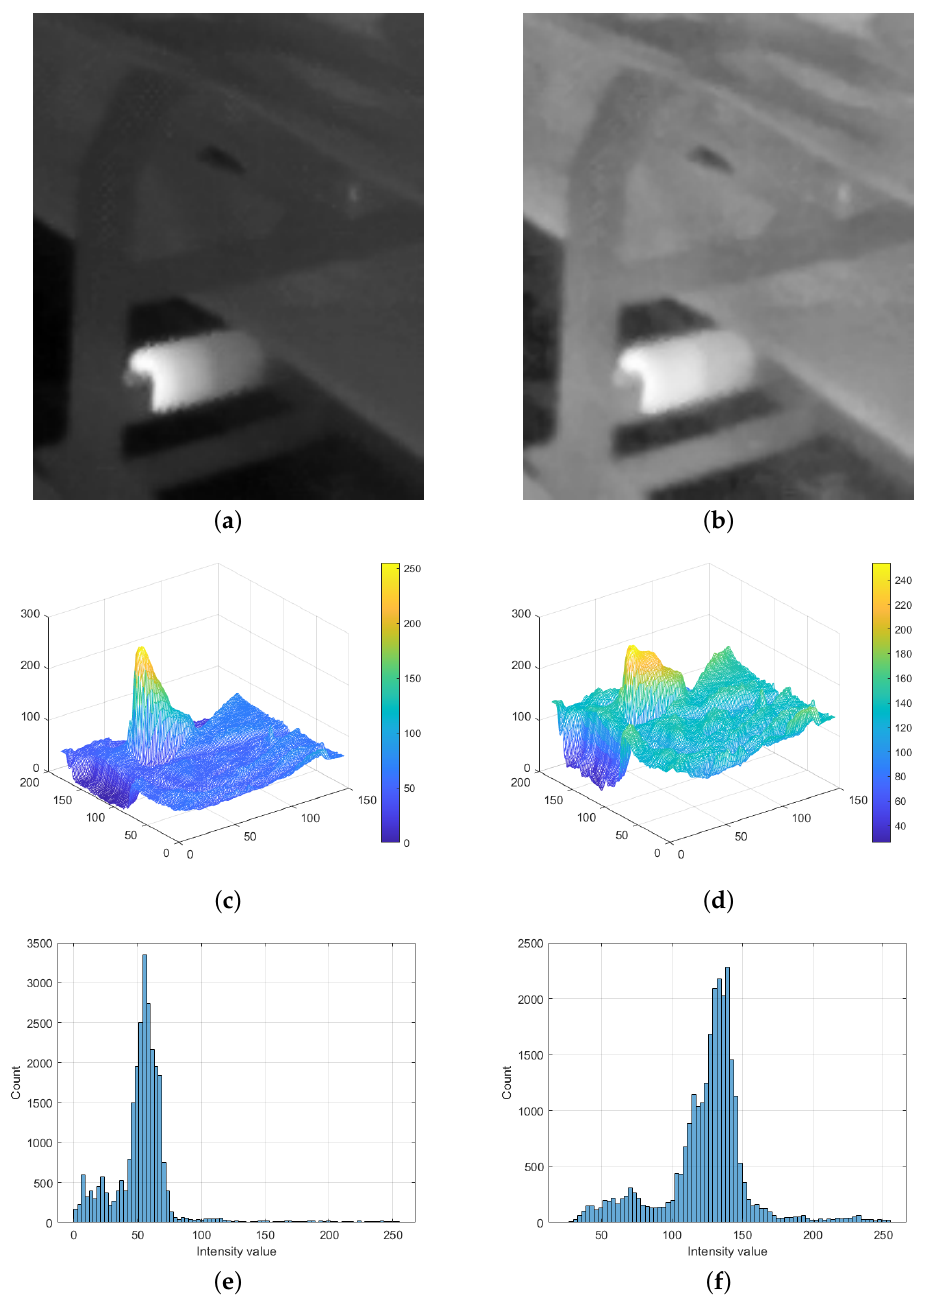
Figure 4. Comparison of pre-processed and orginal IR image after modification through pre- processing stages. ( a ) Original ROI, ( b ) Pre-processed ROI, ( c ) Three-dimensional (3D)-map of original ROI, ( d ) Three-dimensional (3D)-map of pre-processed ROI, ( e ) Histogram of orginal ROI, ( f ) Histogram of Pre-processed